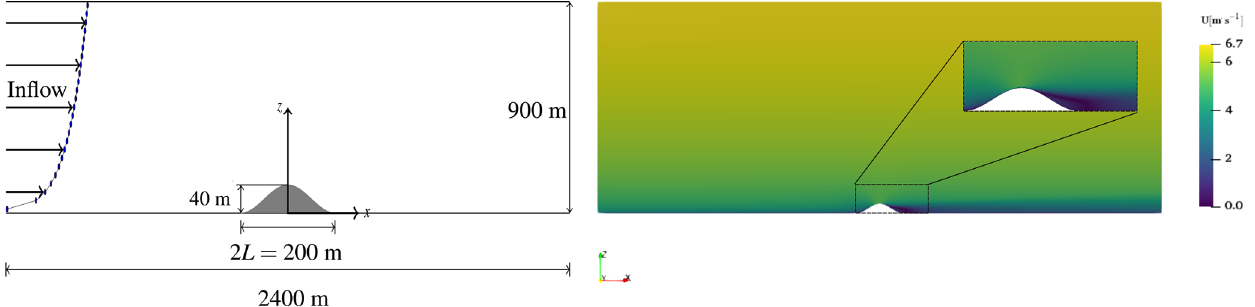
Figure 6. Main dimensions of the test case with 1000m length in the y direction. The velocity flow field on the plane at the center of the domain, y =